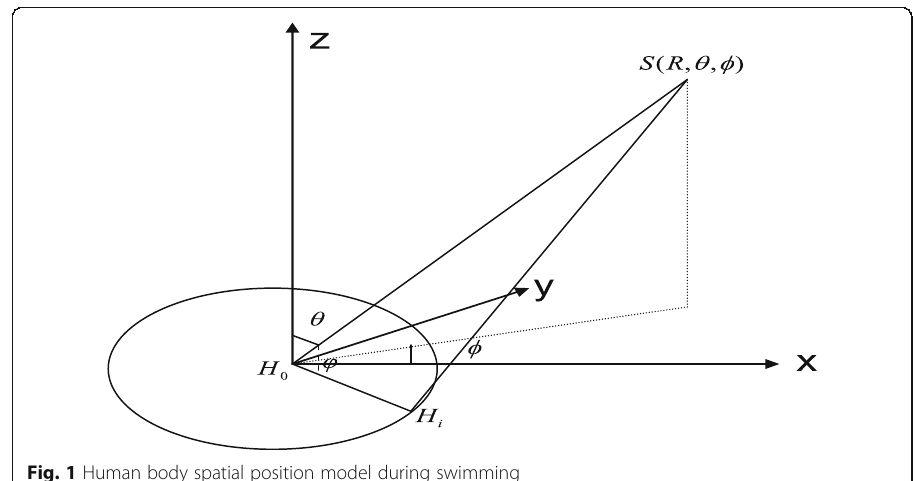
Fig. 1 Human body spatial position model during